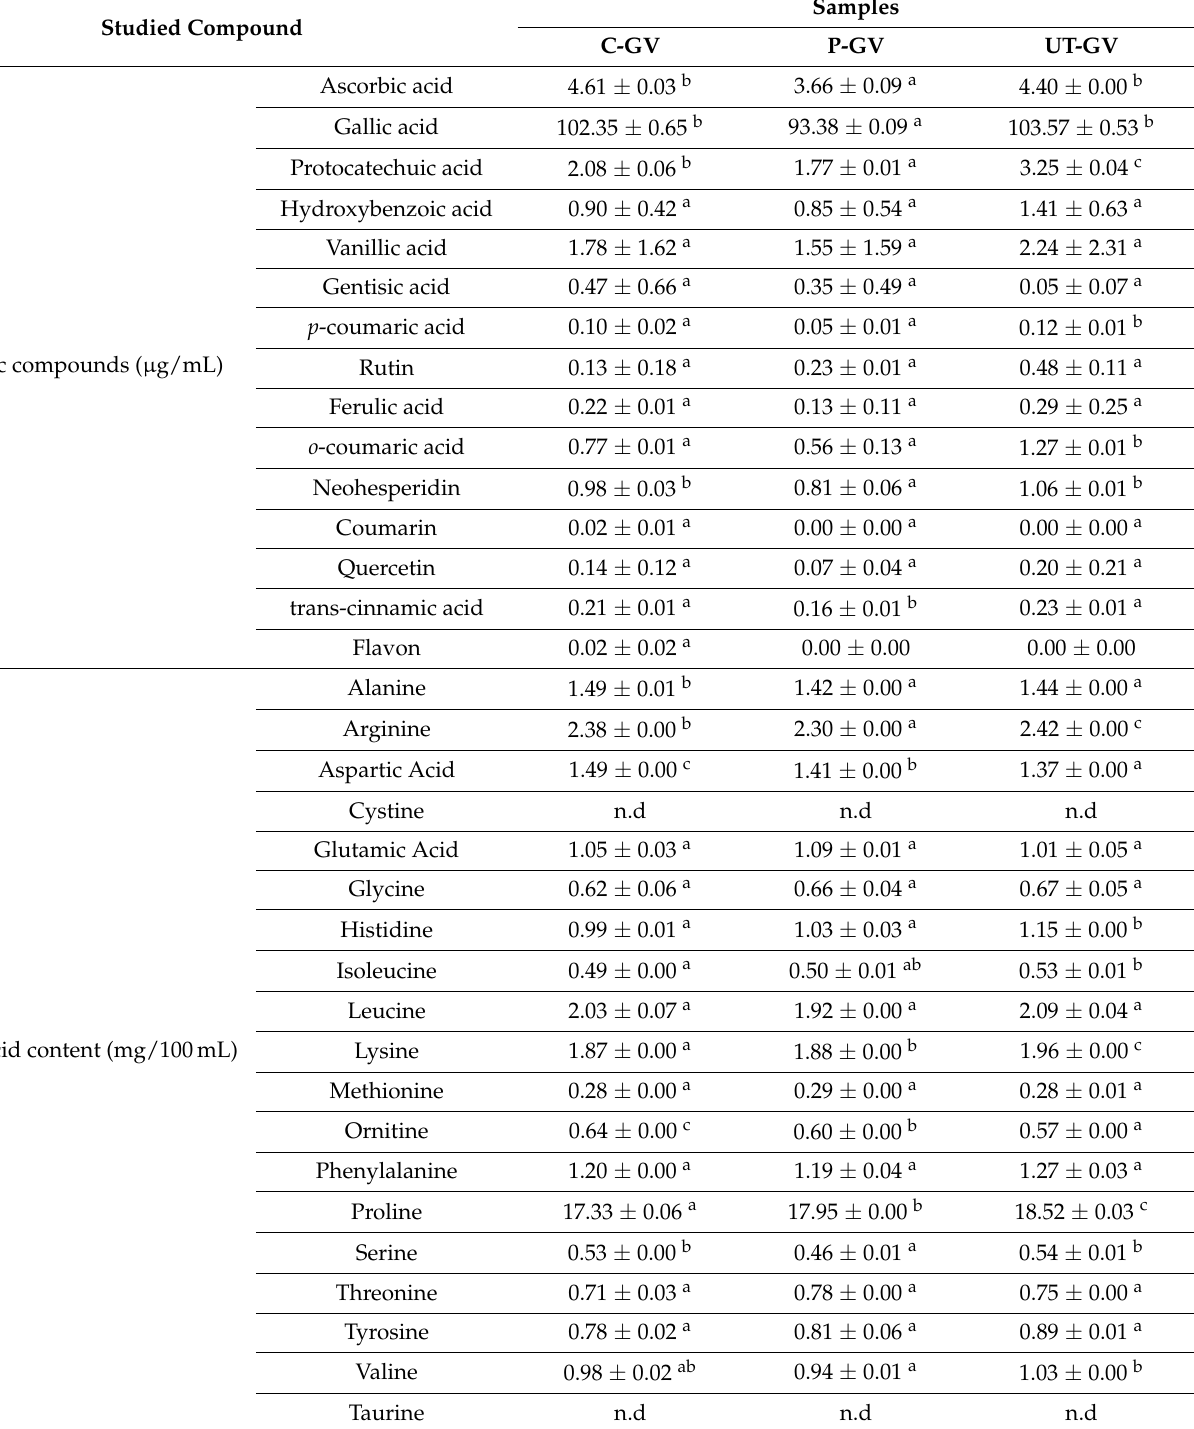
Table 5. Results of phenolic compounds and amino acids of C-GV, P-GV, and UT-GV samples. Studied